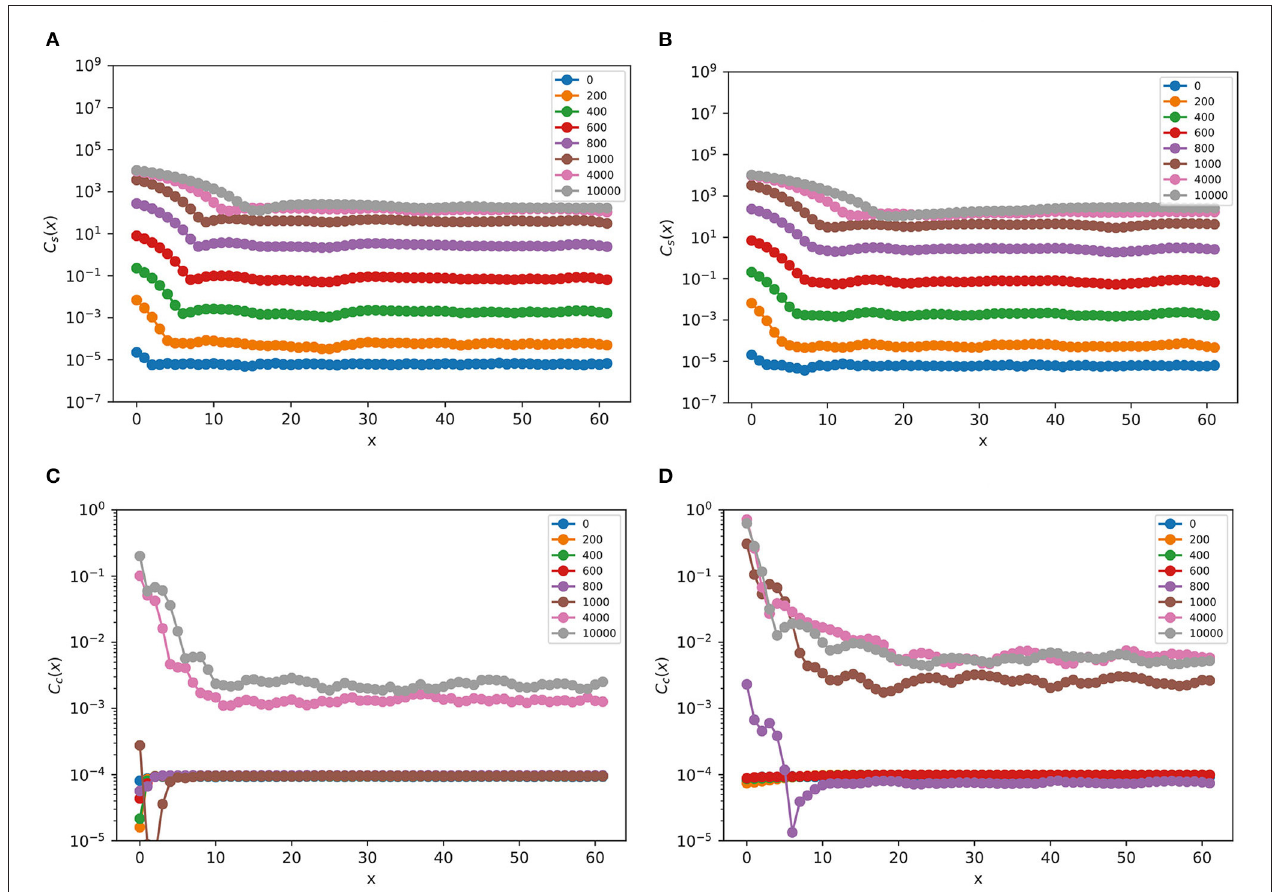
FIGURE 8 | Time evolution of the correlation functions for the nematization and NP concentration from the scalar dynamical Equations (9), as functions of distance x , for low and high NP mobility conditions: (A) C s ( x ) for R t for each correlation function. Initially, the correlation for the nematization increases exponentially with increasing time, while that for the NP concentration remains small. Only after a lag period it rises abruptly. Parameters g